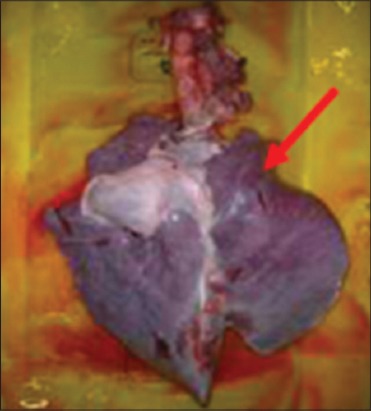
Congested and hemorrhagic lung.